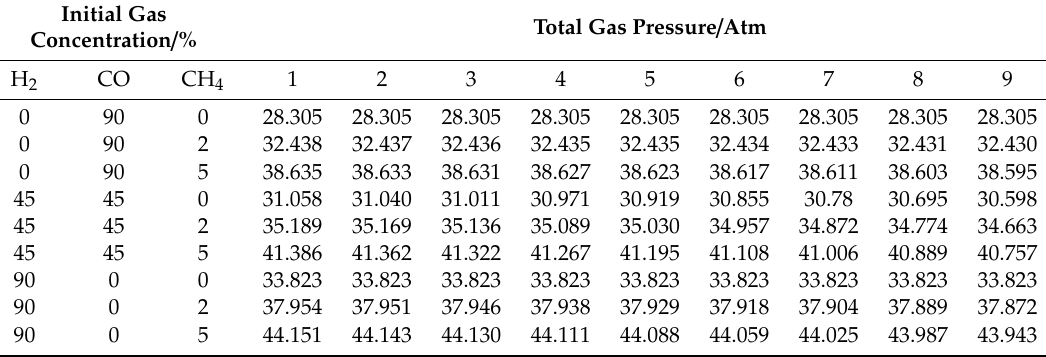
Table 4. The utilization rate of total gas of the selected nine groups of gas concentration under di ff erent